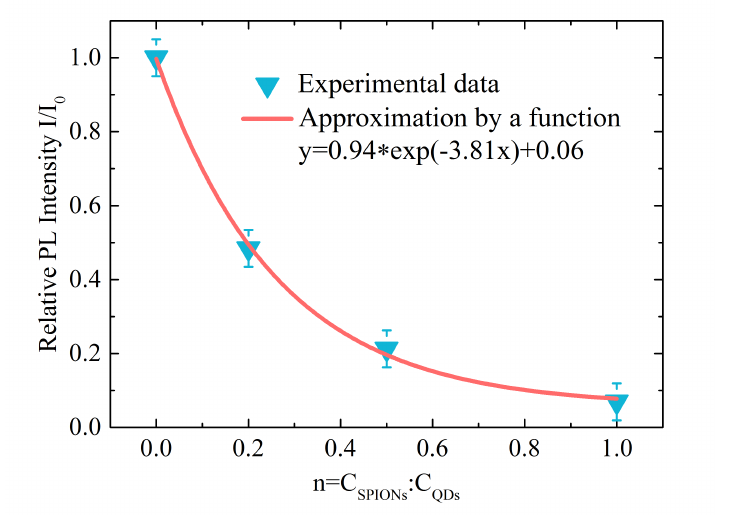
Figure 1. Dependence of the relative PL intensity of the samples in DMSO solution on the ratio of the molar concentrations of C SPIONs /C QDs . The experimental data are approximated by the function y = 0.94 · exp( − 3.81x) +